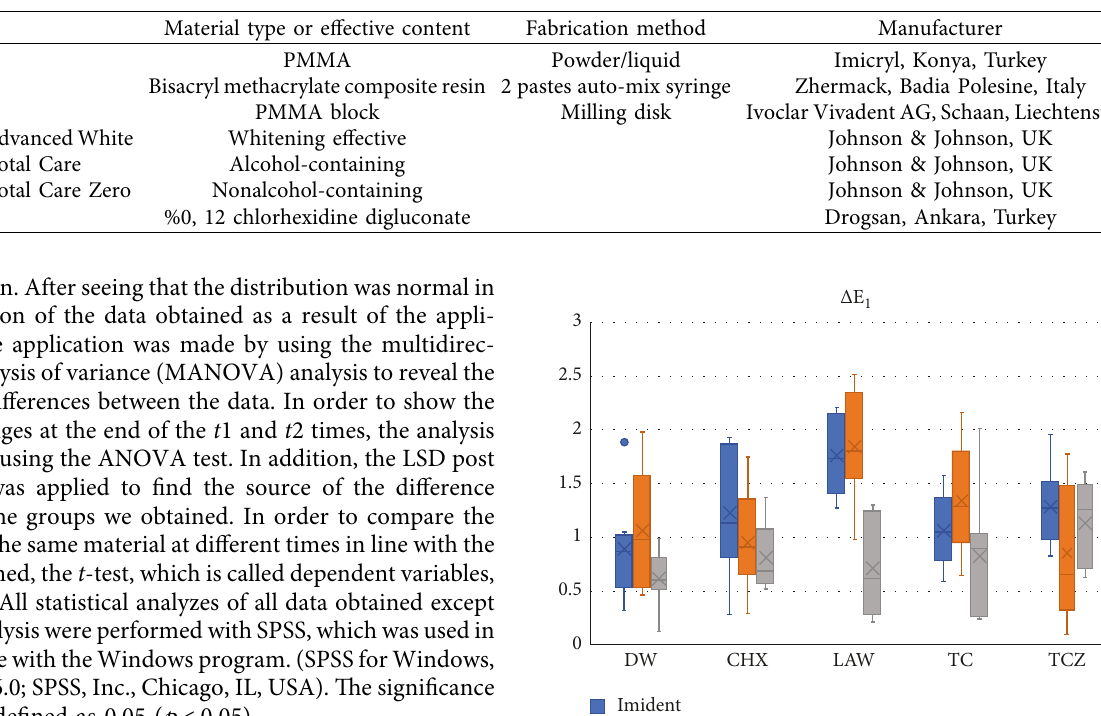
Table 2: Materials used in the study.